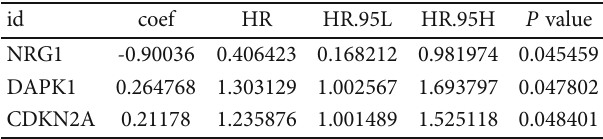
Figure 2: Identi fi cation of CRC-autophagy prognosis signatures and construction of a prognostic risk score system in CRC. (a) Forest plot visualizing hazard ratios of the expression level of the hub autophagy DEGs by performing univariate Cox regression analysis. (b) Patients ’ survival data based on risk score, (c) risk score ’ s distribution curve, and (d) heat map of the PSI value of each prognostic signature. Table 2: The detailed information of AUT signatures related to overall survival in CRC patients ( n = 447